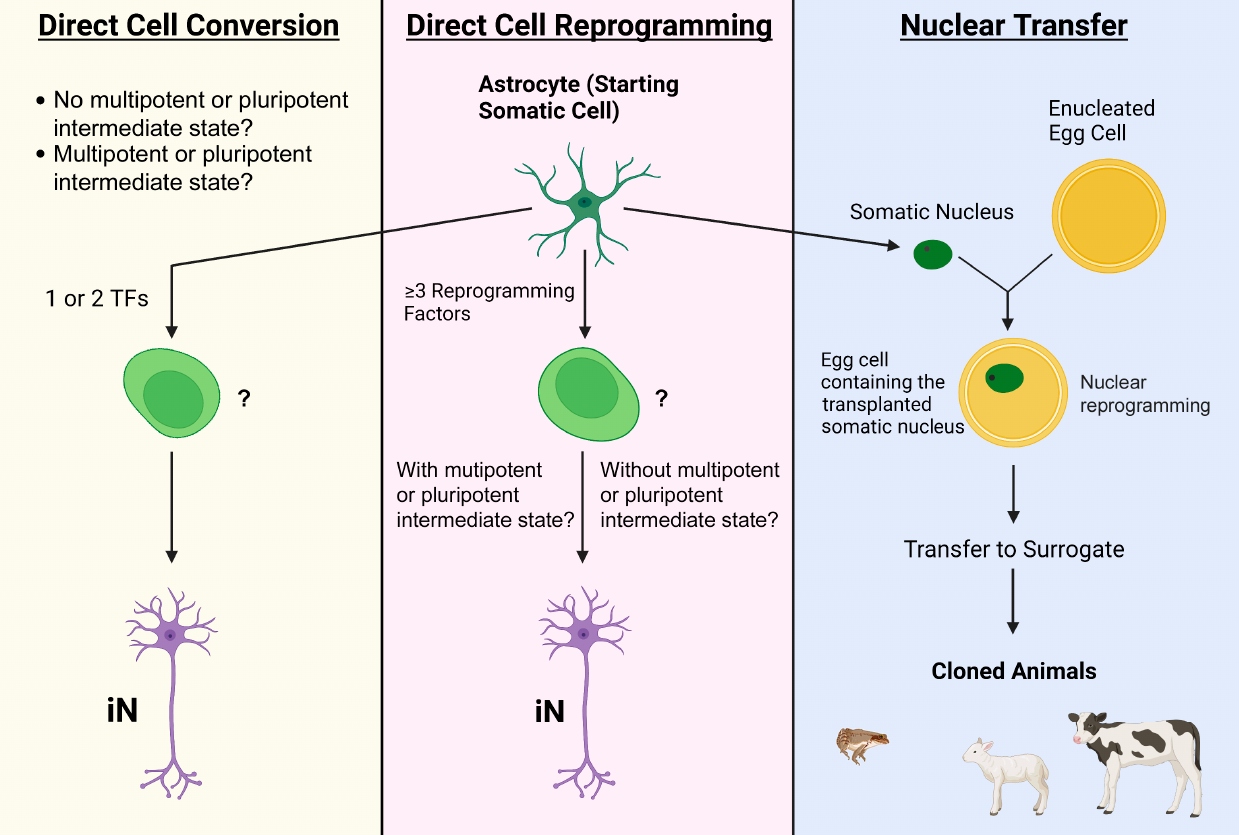
Figure 1. Summary of the formulas used in this paper to describe direct cell conversion and direct cell reprogramming relative to the somatic nuclear transfer presentation. For this review, we have tried to distinctively describe direct cell conversion and direct cell reprogramming as per the experimental methods utilized to initiate the process (see text for rationales and purposes). In the current research field, however, the two terms are interchangeably used. ( Left ) Direct cell conversion is used here to describe the change of one somatic cell type (e.g., astrocyte) into another (e.g., iN) via the intervention of 1–2 transcription factors (TFs), presumably without passing through a multipotent or pluripotent-like state. It was proposed by some investigators as a straightforward method to attain the desired cell type from an already differentiated cell. ( Middle ) Direct cell reprogramming is defined by the manipulation of ≥ 3 TFs (or other factors including small molecules, signaling pathway modulators, etc.) that affect multiple epigenetic and/or genetic elements. ( Right ) Somatic nuclear transfer, the original concept of nuclear/cell reprogramming, is a process through which the nucleus of the somatic cell is removed and transplanted into an enucleated egg cell/ovum that subsequently becomes a zygote before being transplanted into a surrogate or gestational carrier. The new-born animal will be a DNA clone of the somatic cell nucleus donor. Note: the same set of scientific questions remain to be answered for either direct cell conversion or direct cell programming, despite the difference between their initiation recipes (see text for more discussions).